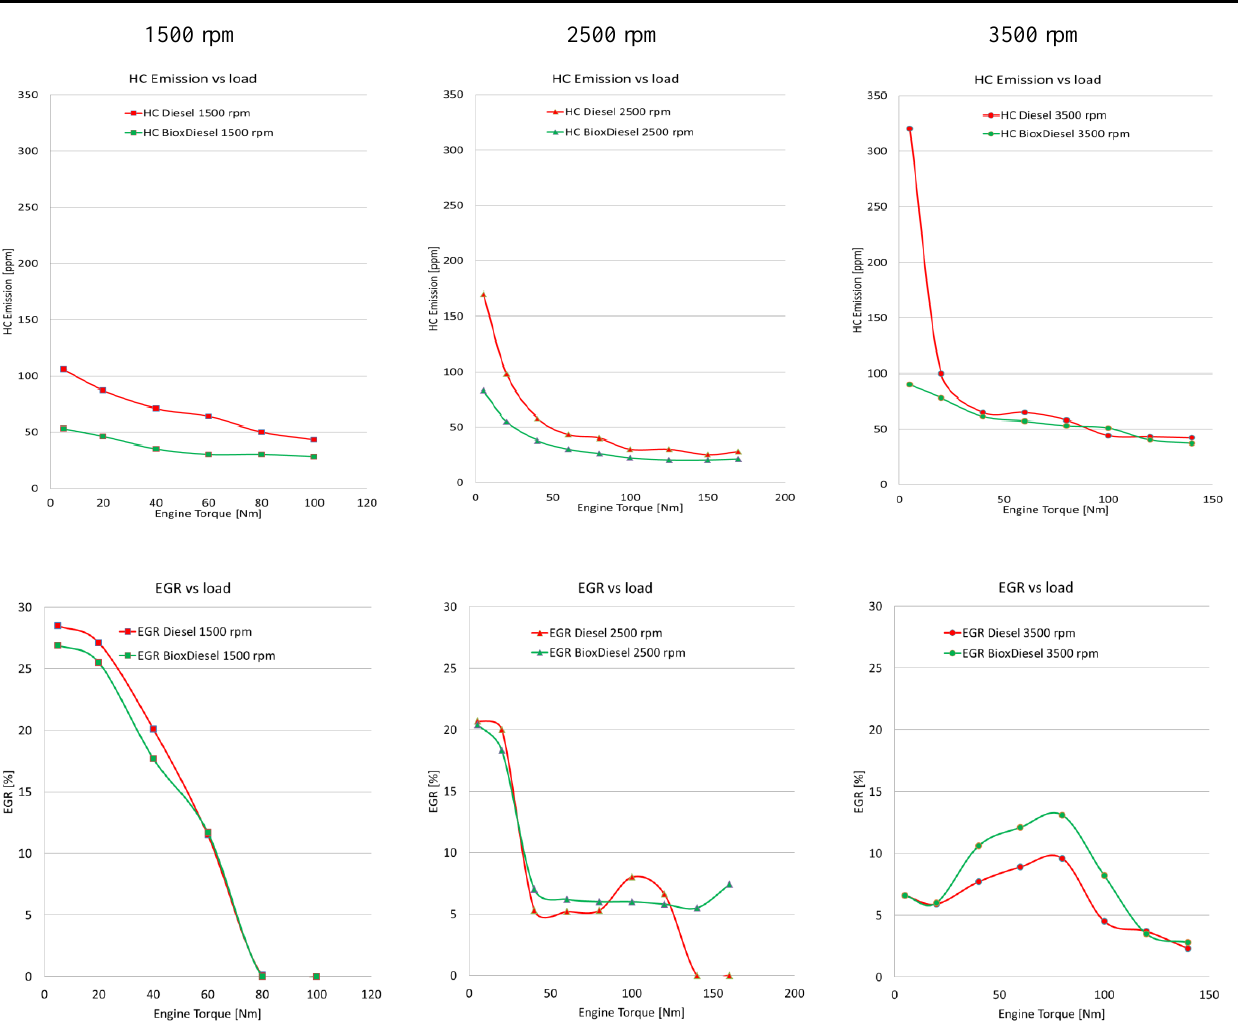
Fig. 10. Comparison of unburned hydrocarbons (HC) emission and degree of exhaust gases recirculation at 1500, 2500, 3500 rpm in variable load of the engine fed with Bioxdiesel and Diesel which contains renewable components. Higher values